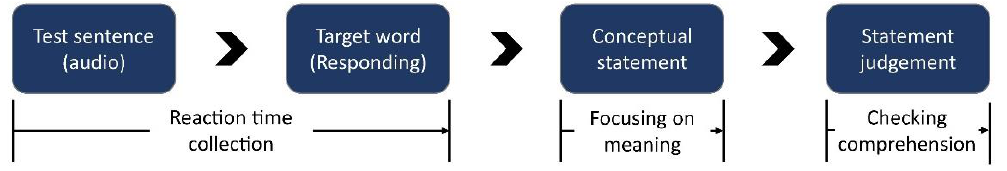
Figure 1. Experimental design.